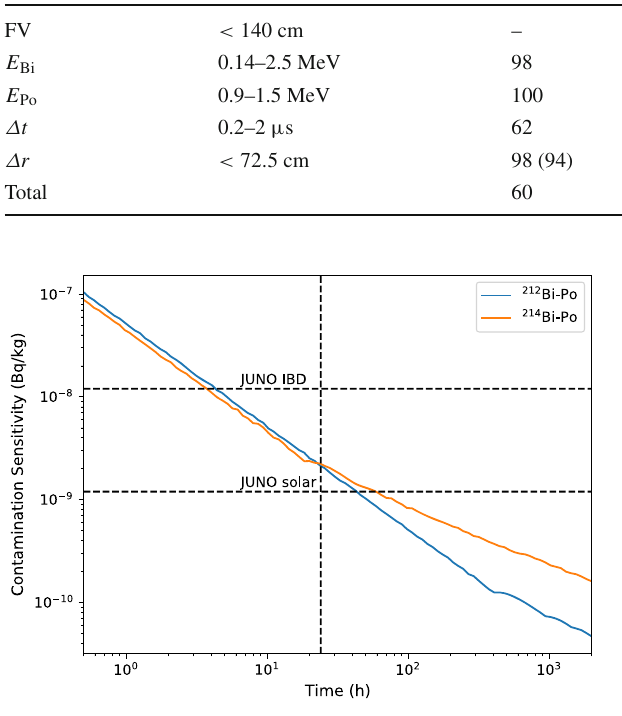
Fig. 17 Sensitivity of OSIRIS as a function of the measurement time for the 212 Bi–Po (blue) and 214 Bi–Po (orange) coincidence searches. ThefluctuationsinthecurvesreflecttheinnateuncertaintyoftheMonte- Carlo method (see text). Within a few hours, OSIRIS can verify the JUNO IBD requirement. In order to confirm the contamination level of the JUNO solar requirement, a measurement longer than 1 day is